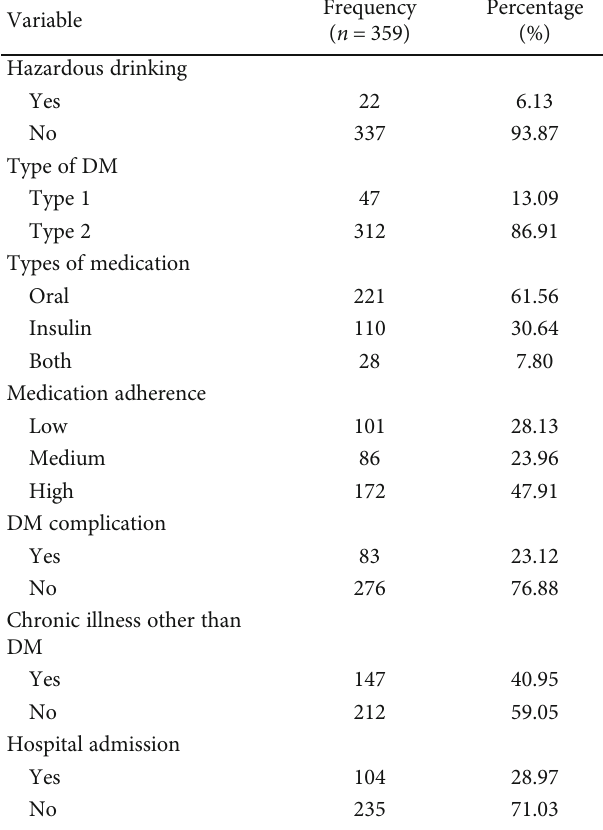
Table 1: Sociodemographic characteristics of diabetes patients at Adama hospital and medical college, Adama city, East Shewa, Ethiopia 2019.